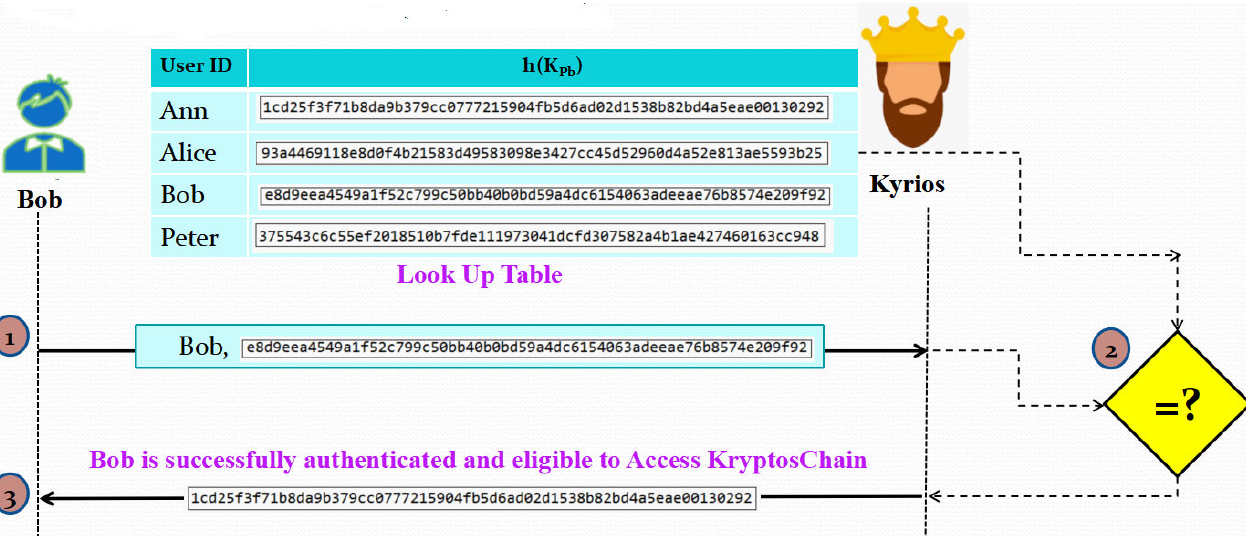
Figure 14. Demonstration of Phase 4: Receiver Authentication.